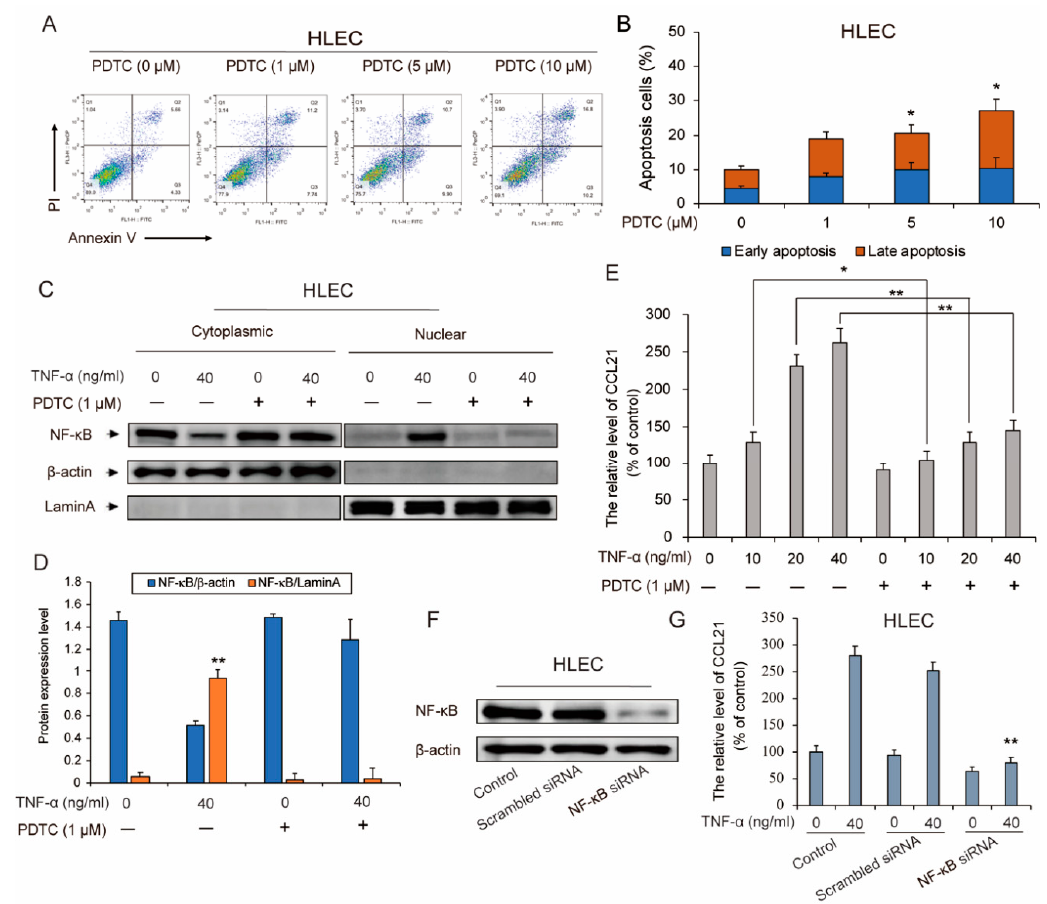
Figure 3. TNF- α -induced secretion of CCL21 involving the NF- κ B signaling pathway. ( A , B ) After HLEC were treated with PDTC (1, 5, and 10 µ M) for the 48-h time point, cells were incubated with Annexin V-FITC and PI as described in Materials and Methods to assess the cell apoptosis. Annexin V-and / or PI-positive cells were counted under a fluorescence microscope and expressed as a percentage of the total cell number. Results were analyzed by flow cytometry. Early- and Late-apoptosis ratios of HLEC are shown; columns represent means of three di ff erent experiments; bars represent standard errors. ( C , D ) Afterwards, HLEC was pre-treated with or without pyrrolidinedithiocarbamate (PDTC) (1 µ M) for the indicated time periods, and then treated with or without TNF- α (40 ng / mL) for the 48 h-time point. The cytoplasmic / membrane and nuclear fractions of the HLEC were analyzed by Western blotting for the NF- κ B nuclear translocation, with β -actin and Lamin A as cytoplasmic and nuclear loading controls, respectively. Data represent the mean ± S.E.M. from three independent experiments. Asterisks denote statistically significant (* p < 0.05 and ** p < 0.01) di ff erences compared with controls by one-way ANOVA. ( E ) ELISA analysis of the secretion of CCL21 following pre-treatment with PDTC (1 µ M) for the indicated time periods, and then treated with or without TNF- α (10, 20, and 40 ng / mL) for the 48-h time point in HLEC. Data represent means ± S.E.M. from three independent experiments. Asterisks denote statistically significant (* p < 0.05 and ** p < 0.01) di ff erences compared with controls by one-way ANOVA. ( F , G ) HLEC were transfected with 10 nM Scrambled siRNA or NF- κ B siRNA, and the expression of NF- κ B was determined by Western blotting. The secretion of CCL21 in TNF- α (40 ng / mL)-treated HLEC which were transfected with Scrambled siRNA or NF- κ B siRNA, was evaluated by ELISA analysis